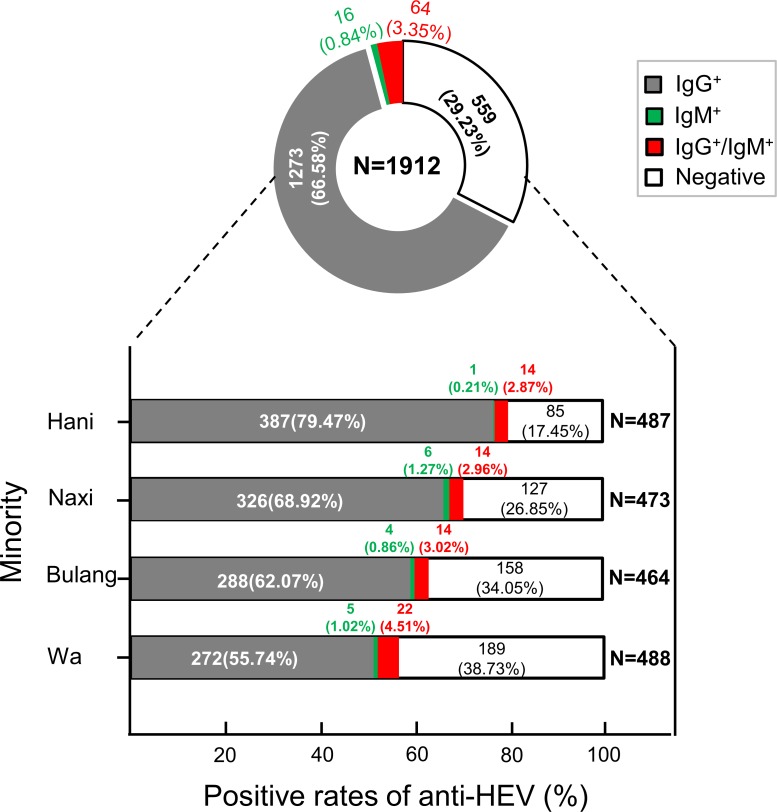
Comparison of anti-HEV IgM/IgG seropositity distributions among four different ethnic groups in Yunnan, China.The different seropositivities are shown in different colors, the anti-HEV IgG+ is marked in gray, anti-HEV IgM+ is highlighted in dark blue, and anti-HEV IgG and IgM co-positive is marked in red.